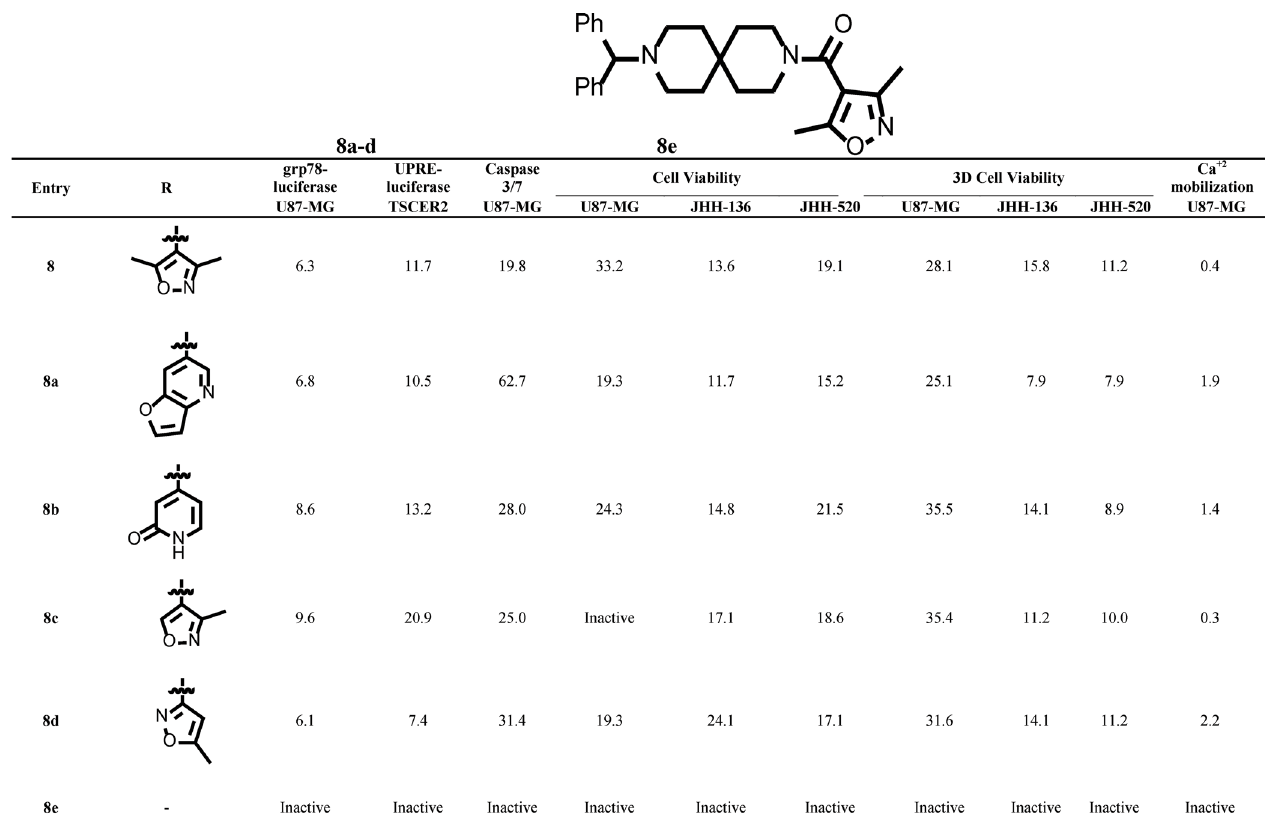
Fig 5. Chemical structure and AC50 ( μ M) of compound 8 analogs in qHTS assays. Efficacy cutoffs are the same as in Fig